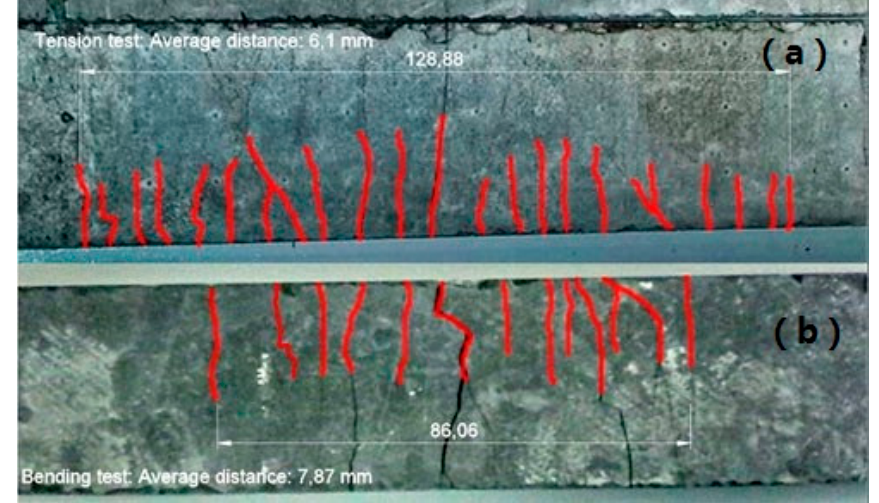
Figure 6. Cracking maps of two composites from the same plate tested under tensile ( a ) and bending test ( b